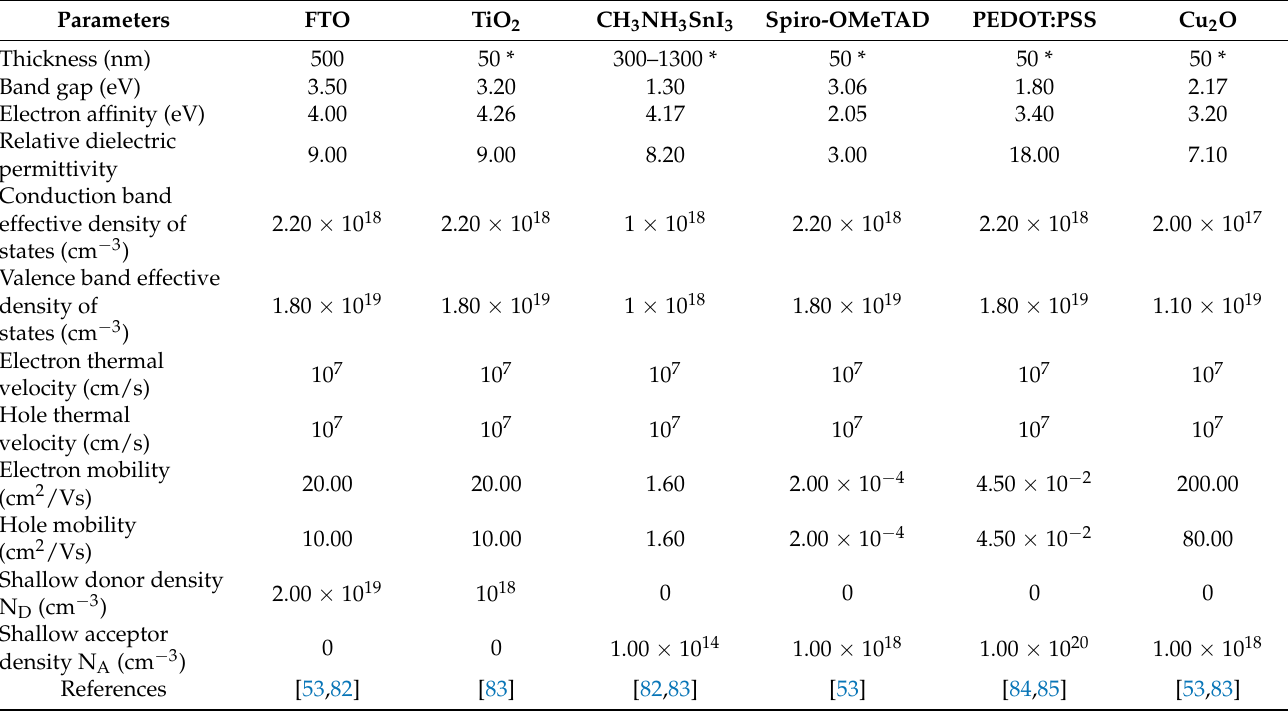
Table 1. Parameters of solar